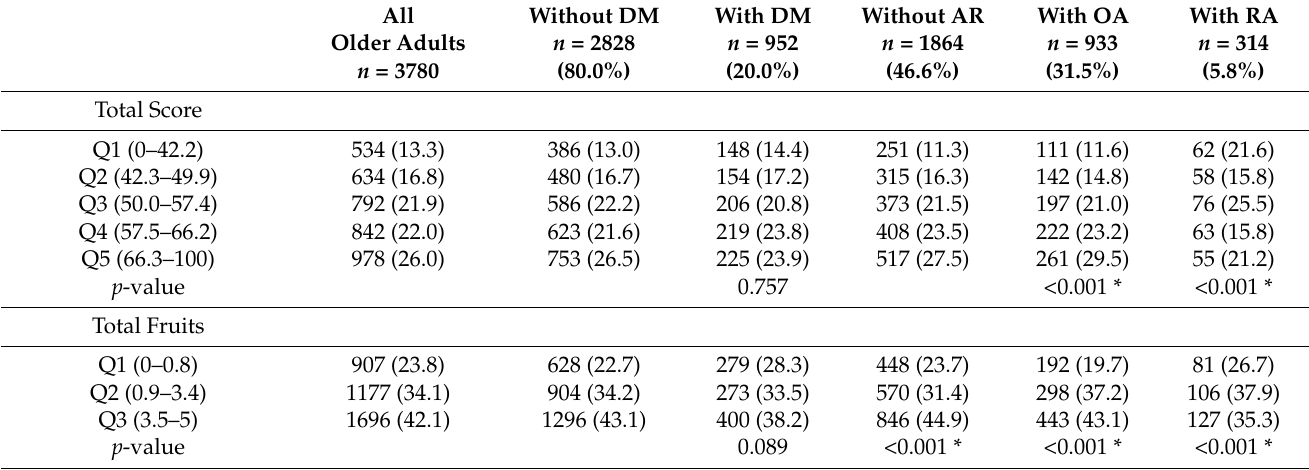
Table 4. Dietary characteristics of older US adults by self-reported diabetes mellitus status and arthritis status: NHANES